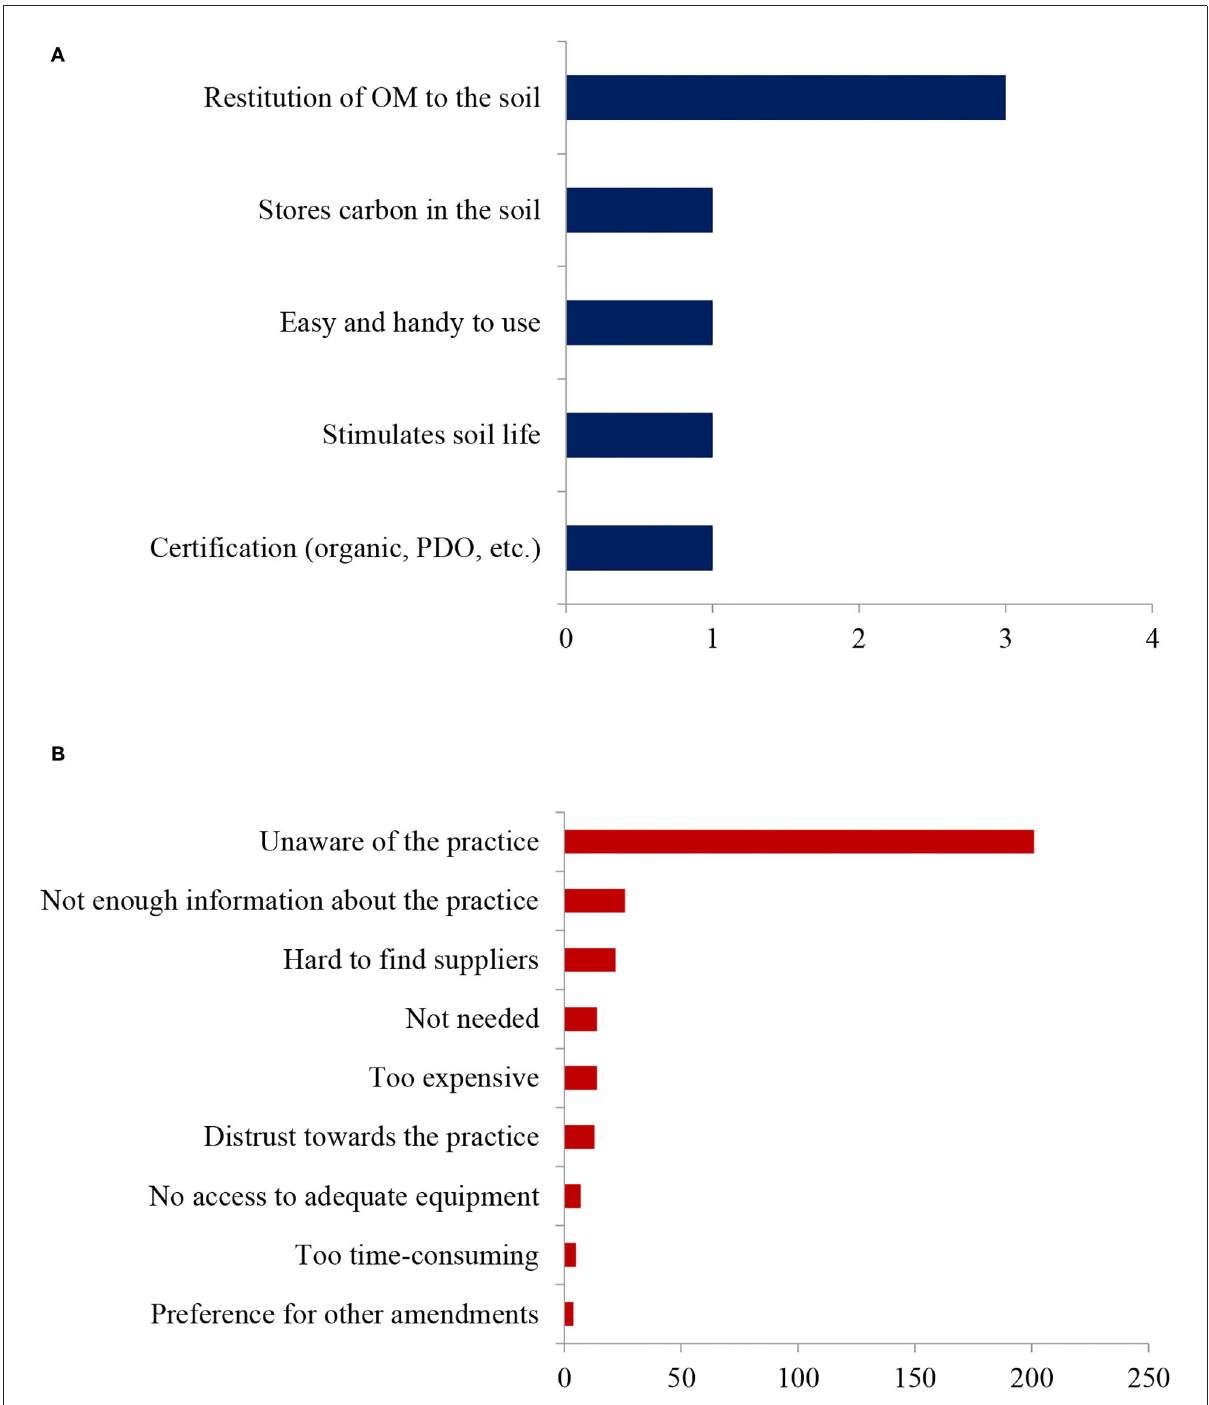
FIGURE2 Motives (A) and barriers (B) to the adoption of biochar amendments in viticulture in France ( n = 6 and 279, respectively). Several responses were possible for each respondent. OM, organic matter; PDO, protected designation of origin.